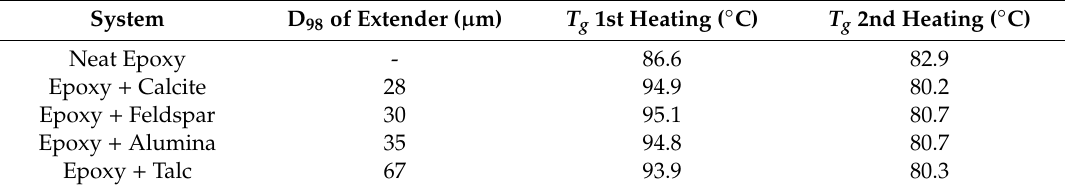
Figure 2. First heating ( a ) and Second heating scan ( b ) of the coatings prepared with extenders of different particles sizes. For coatings with calcite and talc, 2 samples were analyzed. Table 3. T g of the coatings estimated from 1st and 2nd DSC heating curves.